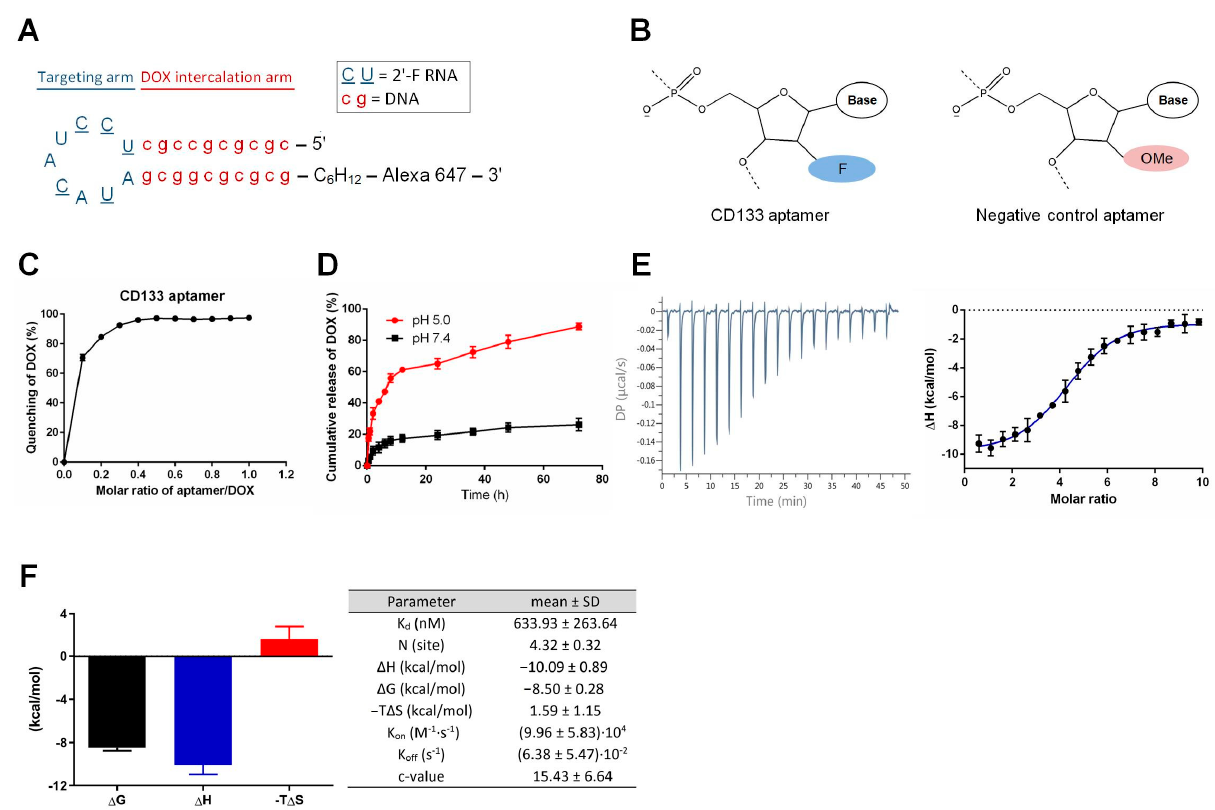
Figure 1. Schematic illustration of the hybrid RNA-DNA CD133 aptamer and characterization of the CD133 aptamer-doxorubicin conjugates (CD133-DOX). ( A ) The predicted secondary structure of the CD133 aptamer. A 10-bp DNA GC stem was engineered to replace the original RNA stem in the RNA aptamers, along with a 2 ′ -fluoropyrimidine modification of all pyrimidines, 5 ′ -methyl-dC in the stem, and an Alexa 647 fluorophore conjugation to the 3 ′ -end of the CD133 aptamer. A hexylamine cap of the CD133 aptamer was added to the 3 ′ -end for enhanced nuclease resistance. ( B ) The negative control aptamers are aptamers of the same sequence as the CD133 aptamer but with a 2 ′ -O-methyl (OMe) modification instead of a 2 ′ -fluoropyrimidine (F) modification at the pyrimidines (C and U), which changes the three-dimensional structure of the aptamer and thus abolishes the binding of the control aptamers to CD133. ( C ) In vitro pH-dependent DOX release from CD133-DOX at a pH of 5.0 and 7.4. ( D ) The intercalation of DOX into the CD133 aptamer. The fluorescence quenching of DOX (10 µM) after incubation with different aptamer concentrations (1, 2, 3, 4, 5, 6, 7, 8, 9, and 10 µM, respectively) for 30 min. ( E ) Isothermal titration calorimetry (ITC) of interaction between CD133 aptamer and DOX. Left, representative raw calorimetric data for titration of CD133 aptamer (2 µM) with serial injections of DOX solution (100 µM) (left). Right, binding isotherms resulting from the integration of the raw calorimetric data. ( F ) Left, the thermodynamic signature for titration by stepwise injection of DOX into CD133 aptamers. Right, thermodynamic parameters for DOX binding to CD133 aptamers obtained by ITC at 25 °C. Data shown are means ± SD, ( n = 3).